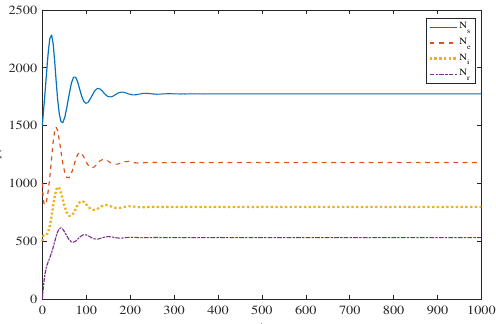
Figure 2. Local asymptotic stability of the endemic equilibrium point H ∗ = ( N ∗ s , N ∗ e , N ∗ τ = 0.